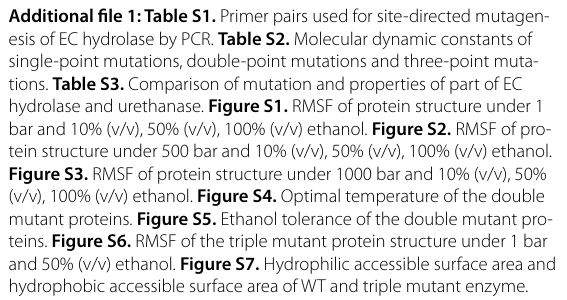
teins. Figure S6. RMSF of the triple mutant protein structure under 1 bar and 50% (v/v) ethanol. Figure S7. Hydrophilic accessible surface area and hydrophobic accessible surface area of WT and triple mutant